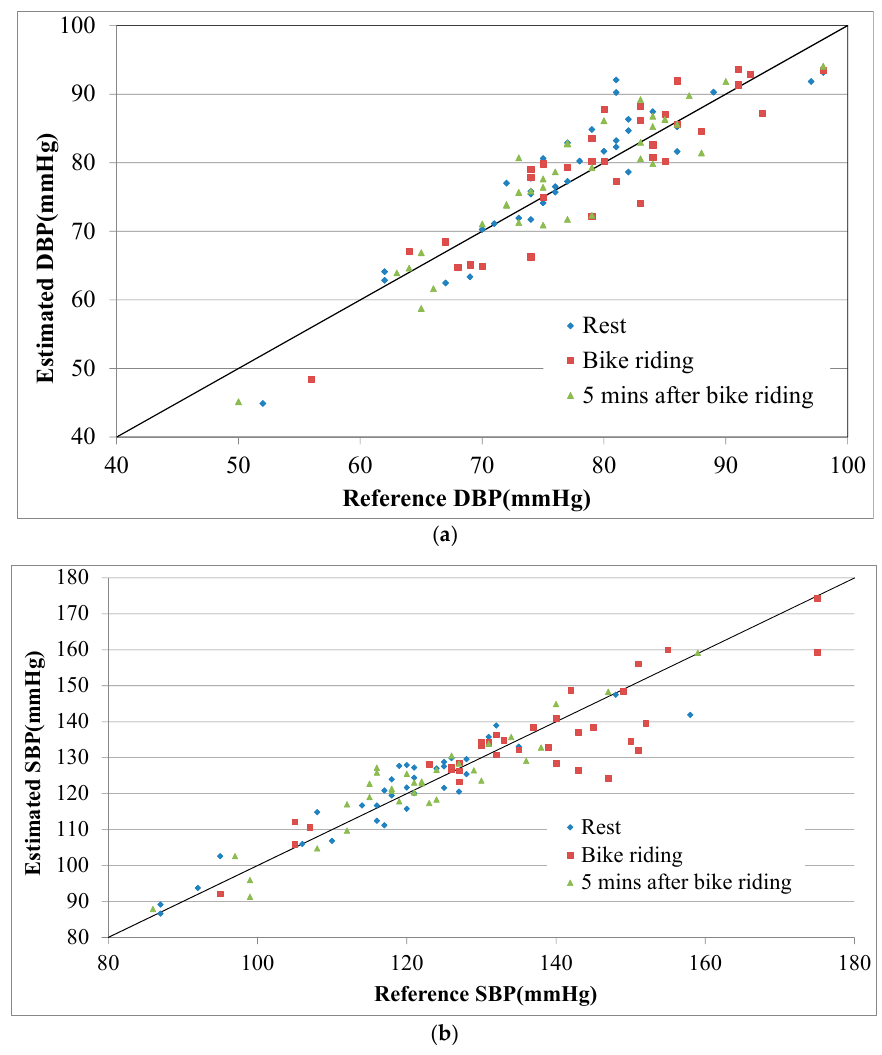
11 of 14 ( b ) Figure 13. Estimated and reference BP versus time. ( a ) DBP and ( b ) SBP. 5. Results and Discussion